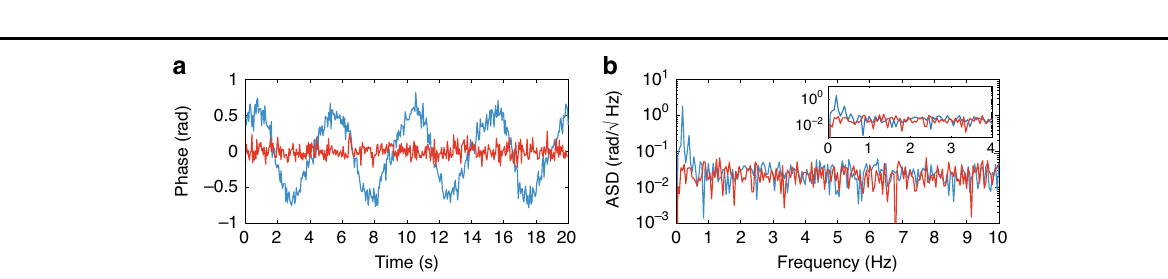
Fig. 4 Sensitivity in the temperature sensing experiment. Comparison of the measured phase signal in the hotspot (blue) and at an unperturbed point outside the hotspot (red) in the a time domain and b frequency